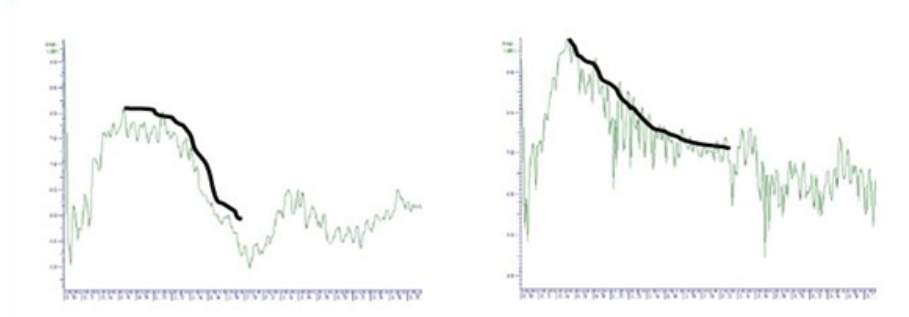
Figure 1 : spectral pattern in velars Figure 2 : spectral pattern in